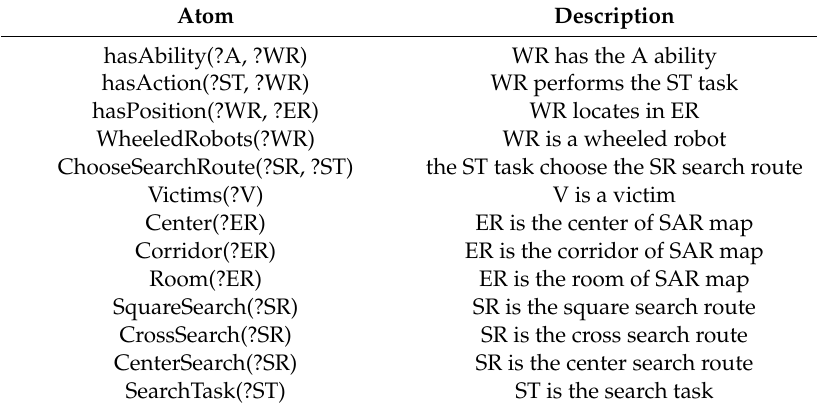
Table 1. The Atom of Semantic Web Rule Language (SWRL) rules contained in the